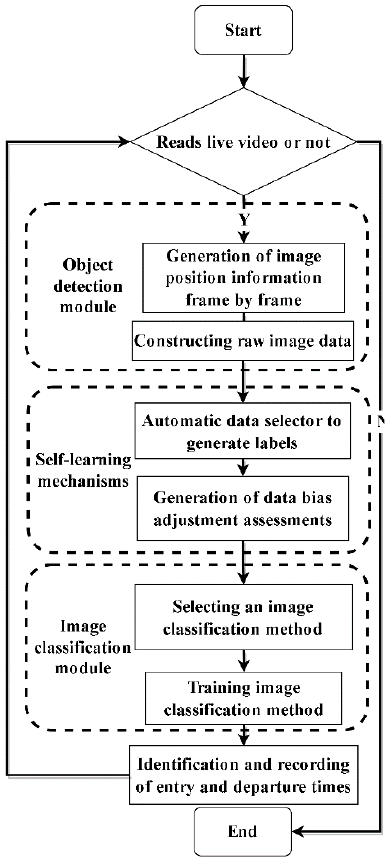
Figure 1. Overall workflow diagram for this paper.